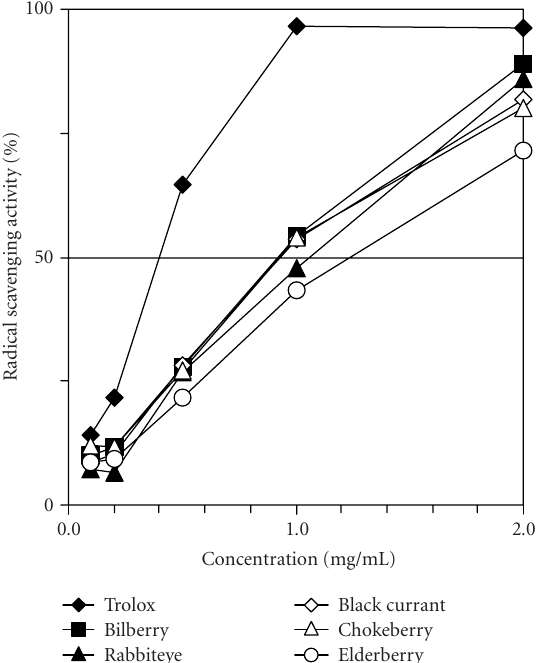
Figure 5. Radical scavenging activities of berry extracts. The berry extracts were incubated with DPPH for 5 minutes, and the absorbance at 517 nm due to DPPH radical was determined. Trolox was used as a positive control.